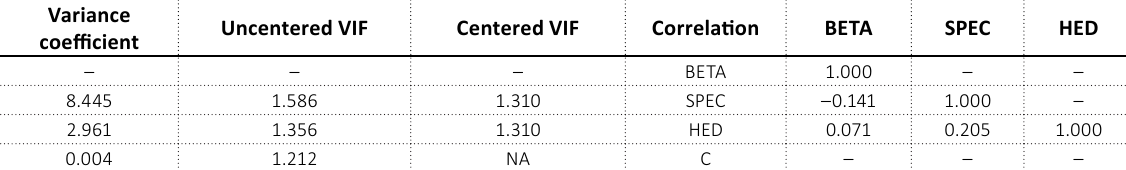
Table 3. The results of test examining multicollinearity among derivatives Variance